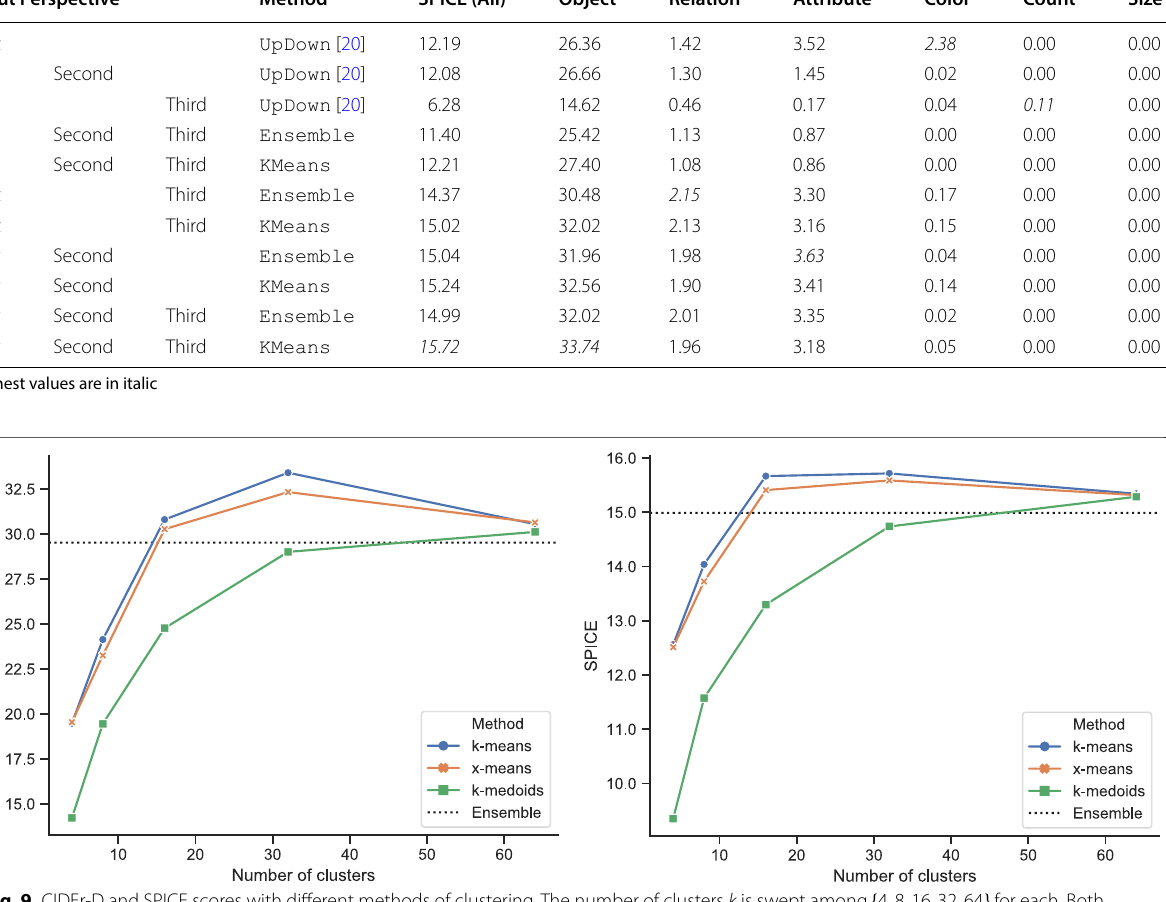
Fig. 9 CIDEr-D and SPICE scores with different methods of clustering. The number of clusters k is swept among { 4,8,16,32,64 } for each. Both metrics show the best scores at k =